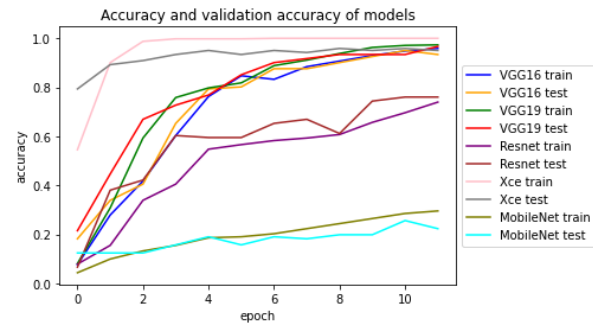
FIGURE VI. ACCURACY AND VALIDATION ACCURACY OF MODELS DATASET